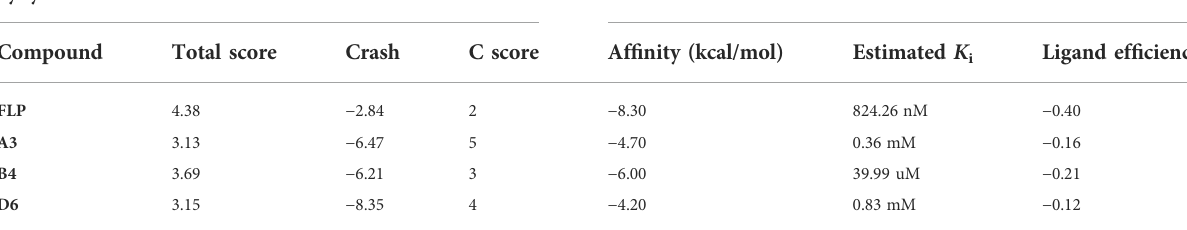
TABLE 4 Model evaluation and docking results by Sybyl x2.0 and AutoDock Vina procedures.